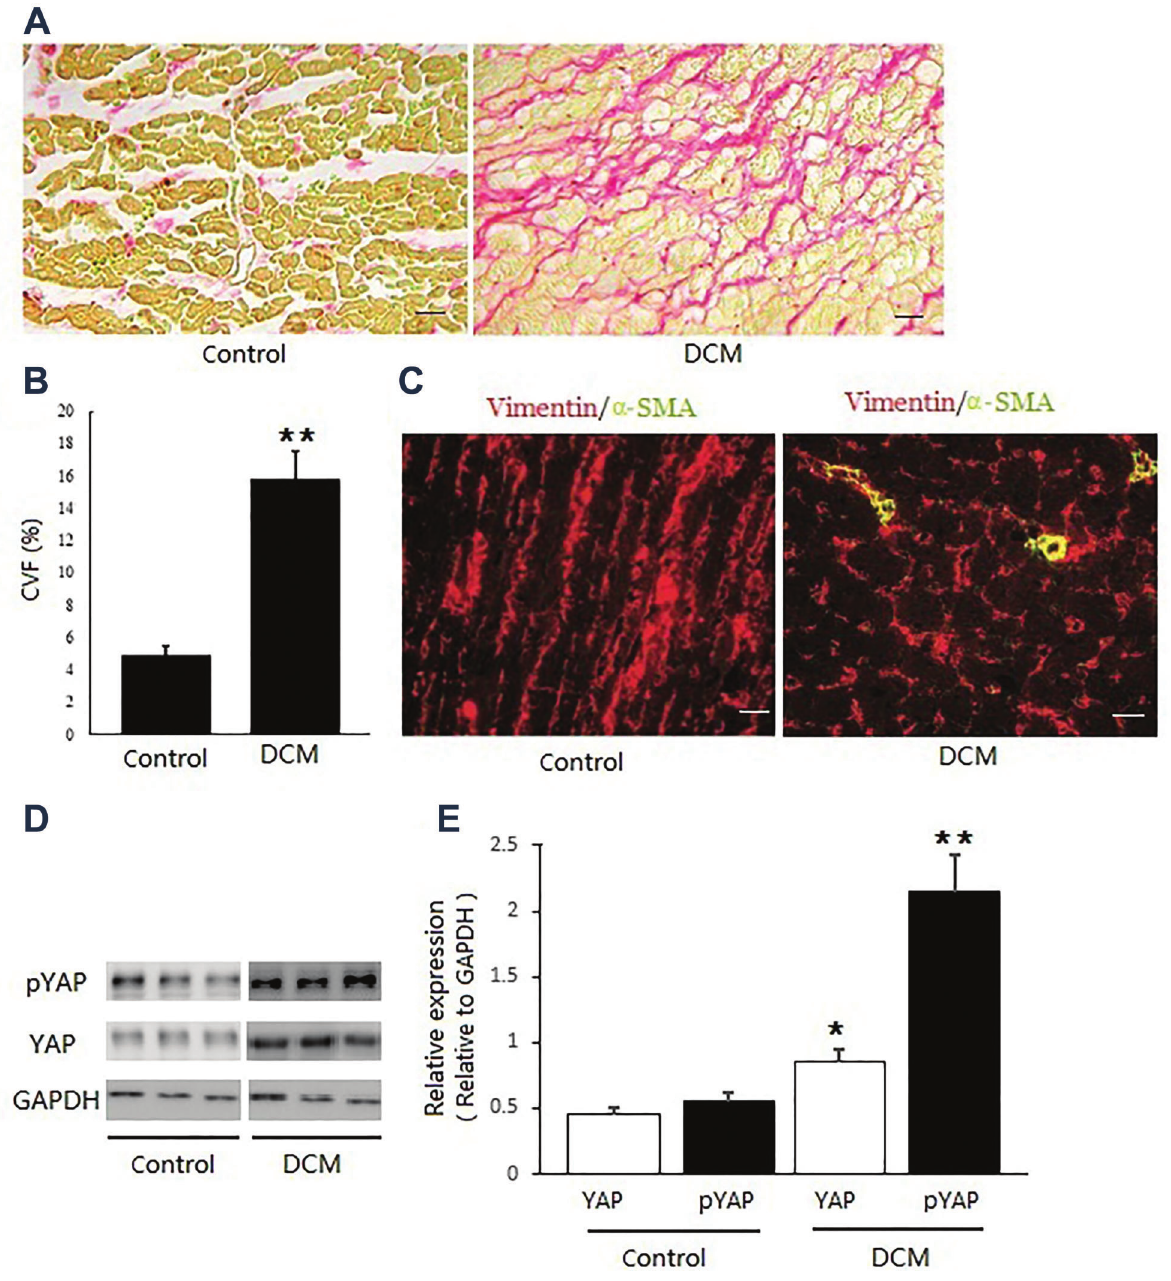
Figure 1. Yes-associated protein (YAP) was activated in the matrix remodeling of dilated cardiomyopathy (DCM). A , Picrosirius red staining indicated an increased collagen distribution in the DCM group. B , Quantitative assessment demonstrated the collagen volume fraction (CVF) signi fi cantly increased in the DCM group. C , Immuno fl uorescence staining of a -smooth muscle actin ( a -SMA) con fi rmed the transdifferentiation of cardiac myo fi broblasts in the pathogenesis of DCM. D and E , The protein levels of YAP and pYAP were signi fi cantly increased in the matrix remodeling of DCM. Data are reported as means ± SD (n=8). *P o 0.05, **P o 0.01 vs control ( t -test). In D , each lane shows protein from a different mouse. Scale bar: 100 m